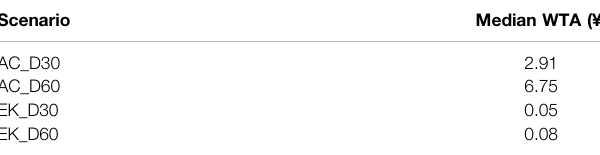
Frontiers in Energy Research |